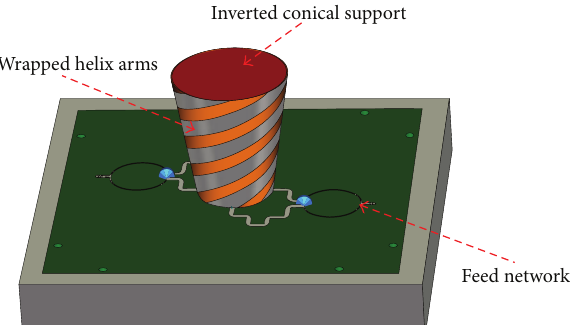
Figure 1: The holistic configuration of the QHA.